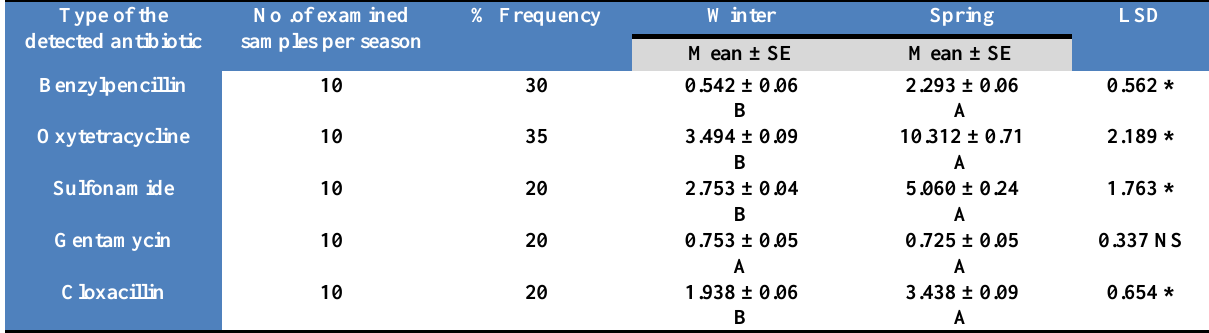
*Horizontal different capital letters revealed a significant (P<0.05) differences between the seasons.